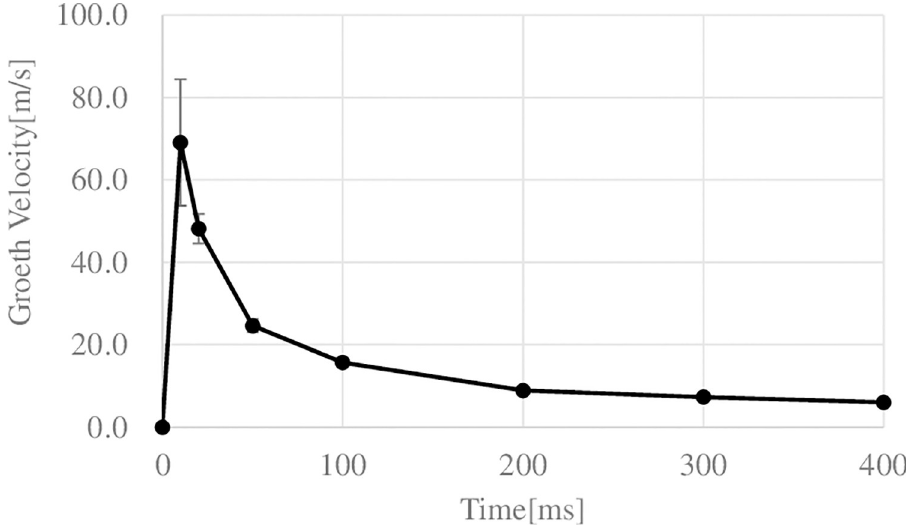
Fig 4. Growth velocity of bubbles generated by laser irradiation in gelatin phantom. Horizontal axis: Elapsed time after pulse laser irradiation. Vertical axis: Growth velocity of bubble in the long axis direction. The bubble growth velocity reached a maximum of 69.1 ± 15.3 m/s (N = 5) at 10 µ s after the start of irradiation. 2.64 ± 0.19 mm, N = 5) at 420 μ s after the start of the irradiation. After that, the bubbles did not burst but shrank and disappeared, and cutting marks on the gelatin phantom were found around the tip of the optical fiber at 1280 μ s after the irradiation onset. The maximum size in the short-axis direction was 1.35 mm (average: 1.42 ± 0.10 mm). After the bubble had disap-